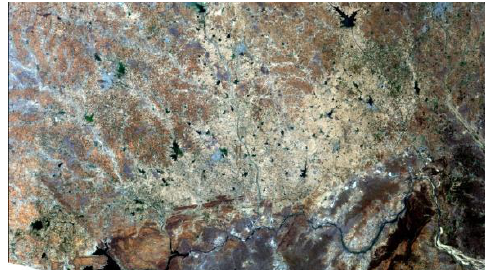
Figure 3: OLI 432-natural image(30m) (Krishna river with left